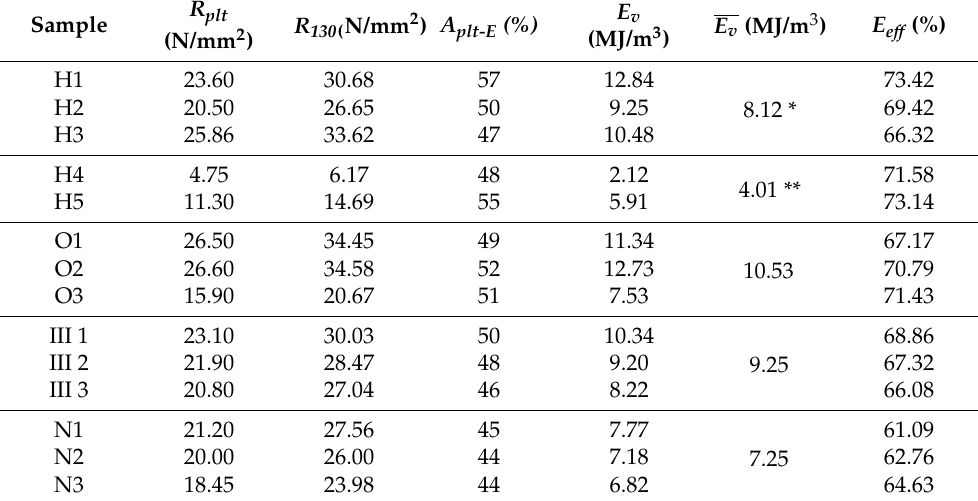
Table 2. Specific energy absorption and specific energy absorption